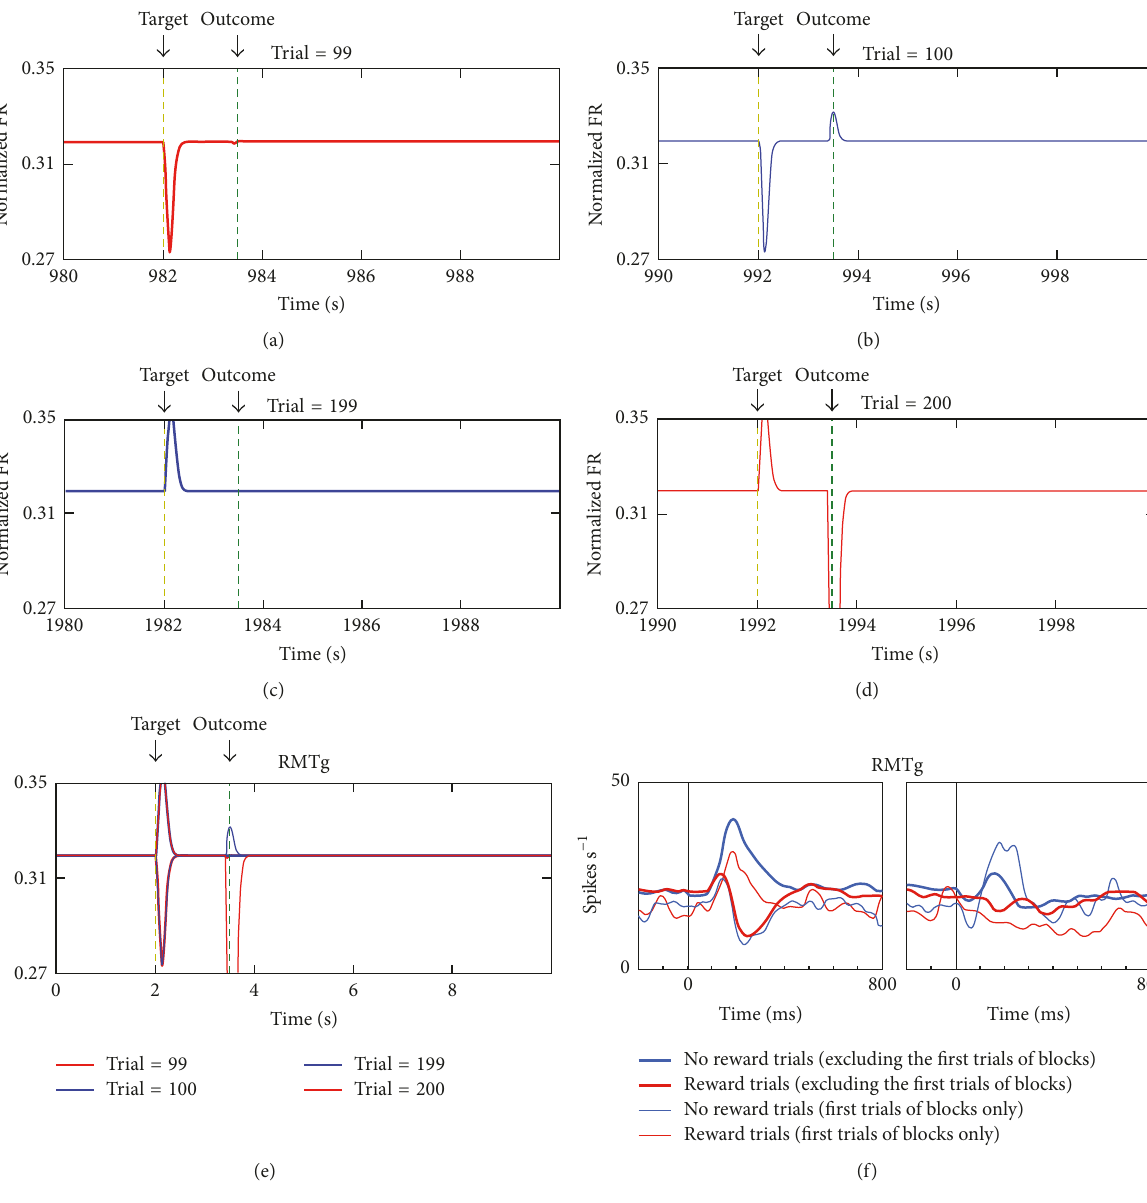
Figure 8: Acquired response of RMTg neurons. (a) ∼ (e) Similar to Figure 6. (f) The physiological experimental result from Hong et al. [3].